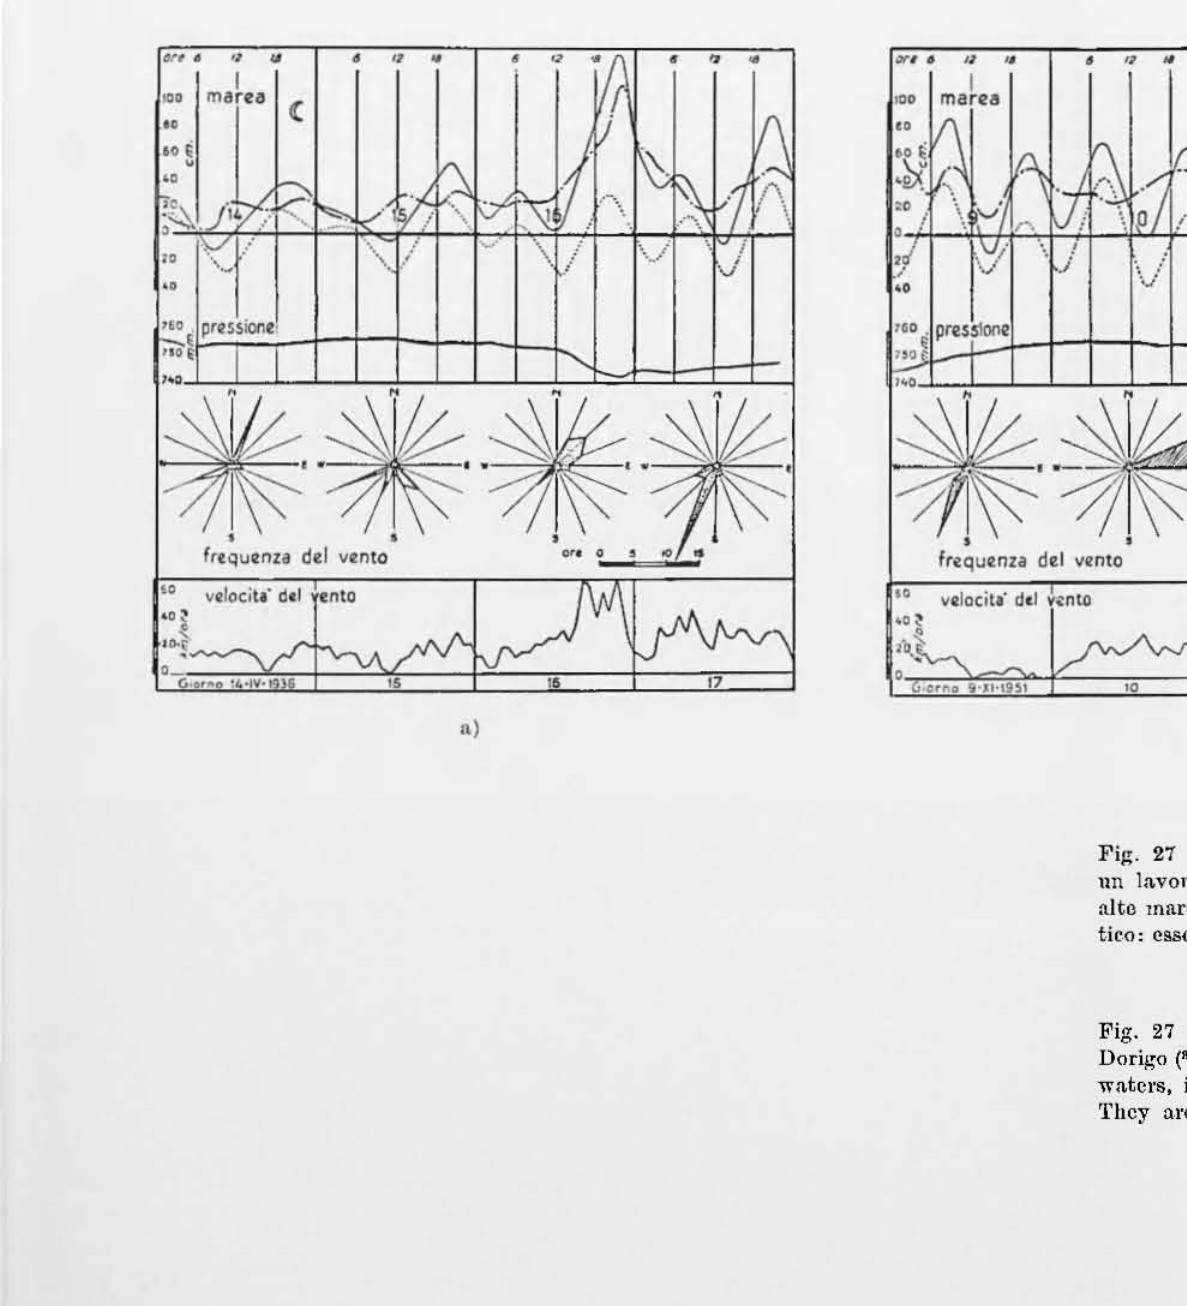
Fig. 27 - Diagrmns al hl cl cl) IInd othofe lIere unrepol'tcd, takcn from a st.udy by I ..